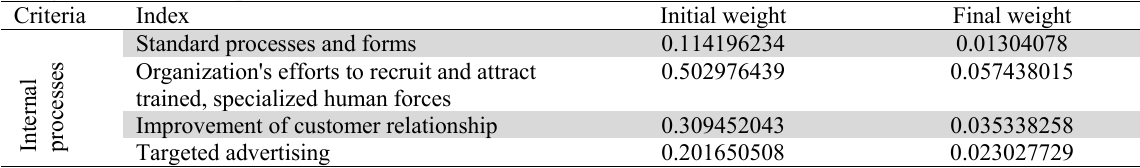
Weights for internal processes criteria